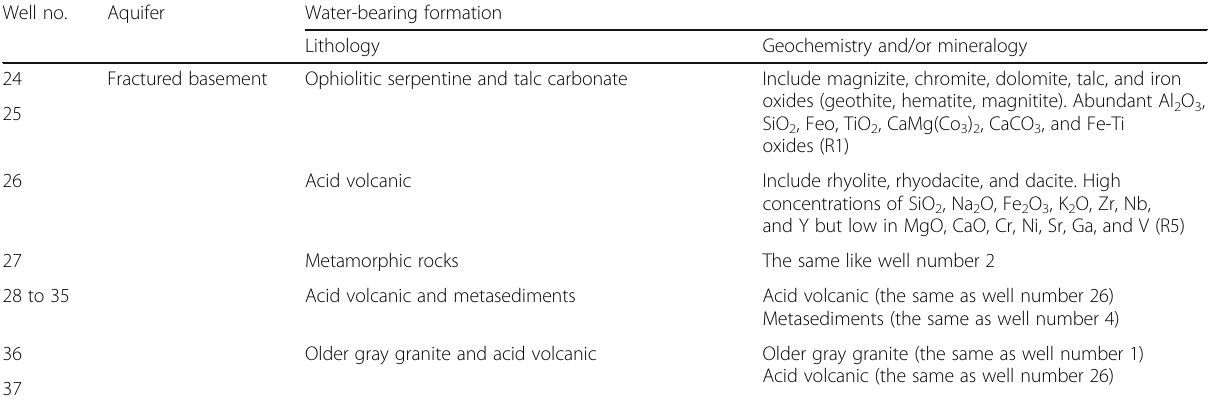
Table 5 Geology and geochemistry of water bearing formation and watershed affecting groundwater wells (Continued) Well no.